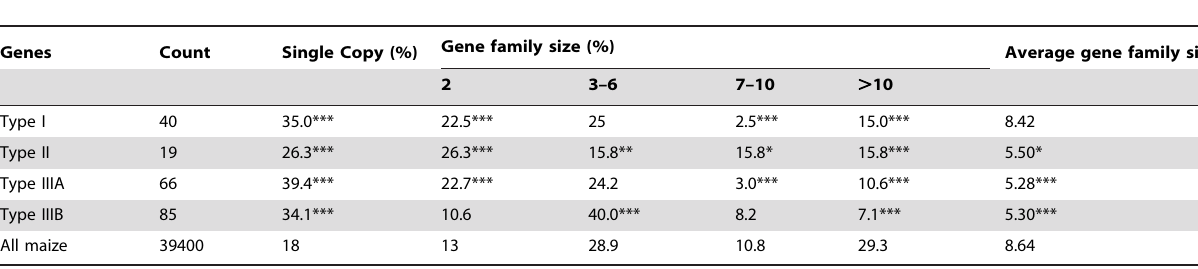
Table 2. Gene family size for genes with unexpected expression